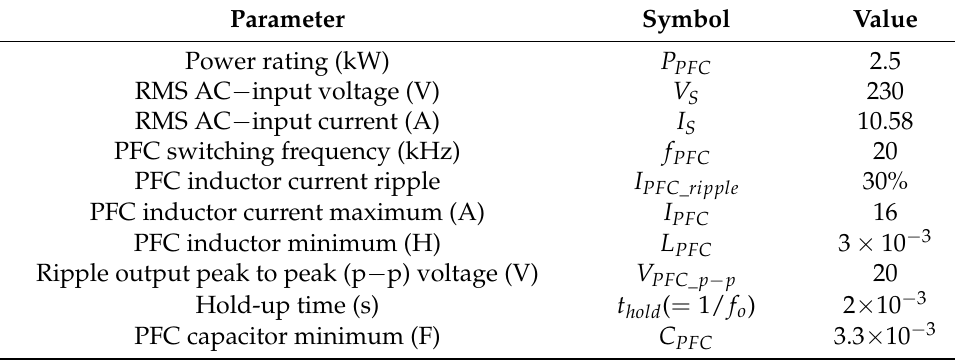
Table 3. Specifications of the boost PFC.